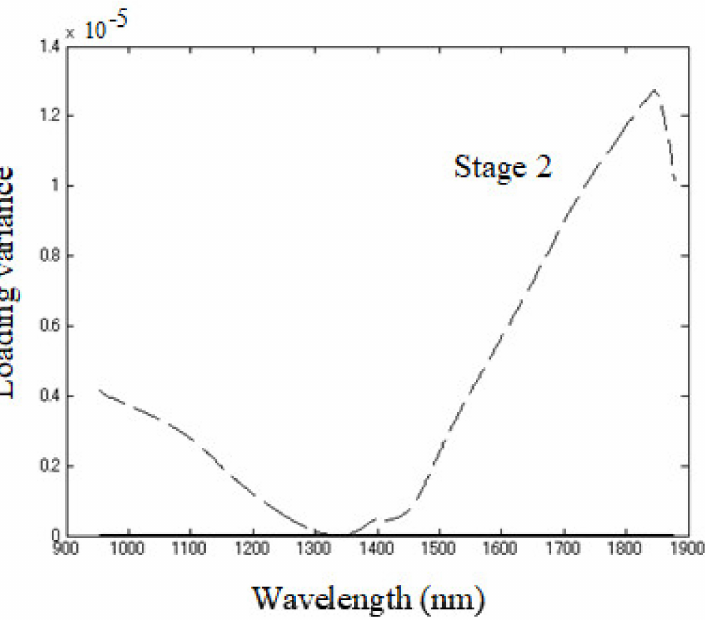
Figure 5. Loading variance for stage two (the period between 3 h 15 min and 4 h 30 min after the beginning of